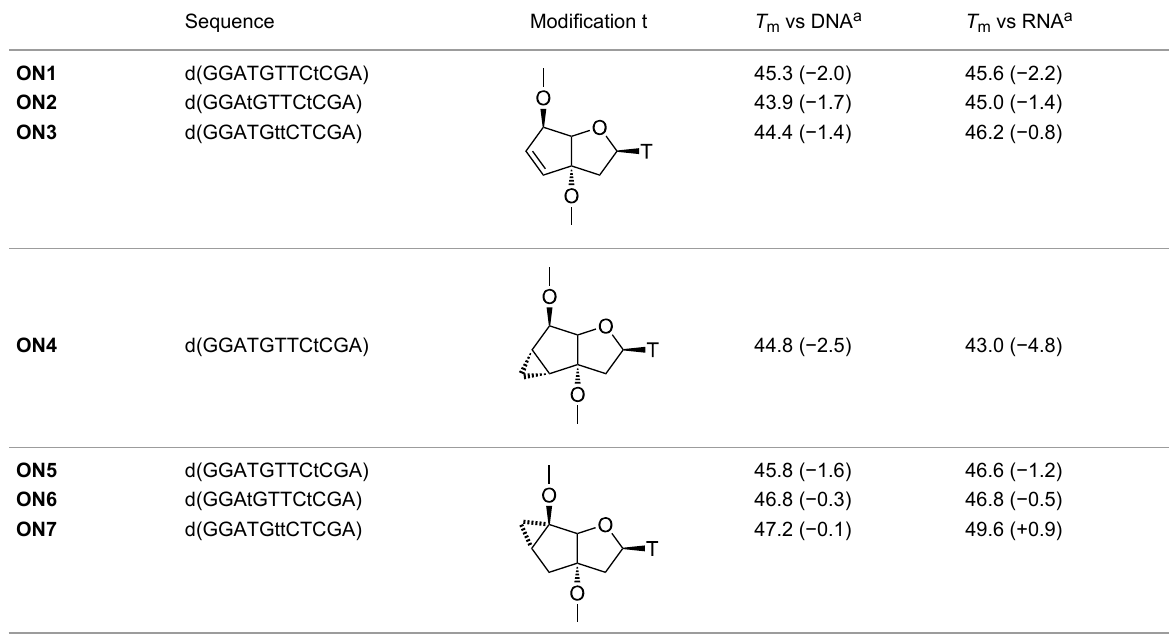
Table 2: Sequence information and analytical data of ON1–7 as well as T m data from UV-melting curves (260 nm) in 10 mM NaH 2 PO 4 /Na 2 HPO 4 , 150 mM NaCl, pH 7.0. Duplex concentration: 1.2 μ M.